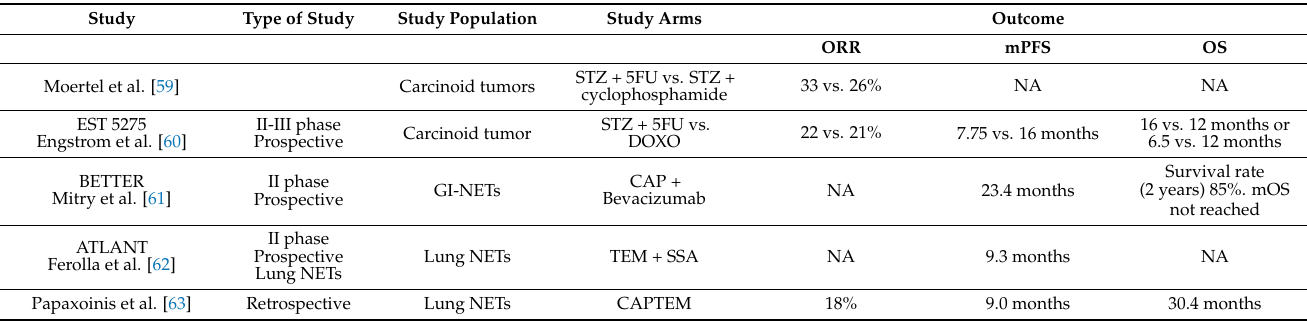
Table 3. Studies and trials of chemotherapy in G1-G2